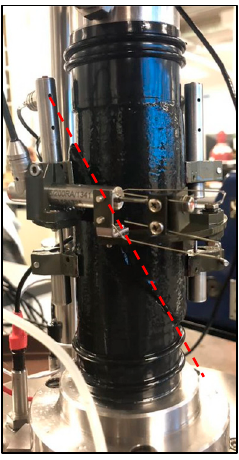
Figure 12. Photograph of specimen HCT after triaxial shearing, showing distinct failure planes (denoted by red dashed line) that are similar to those observed for cemented granular material.